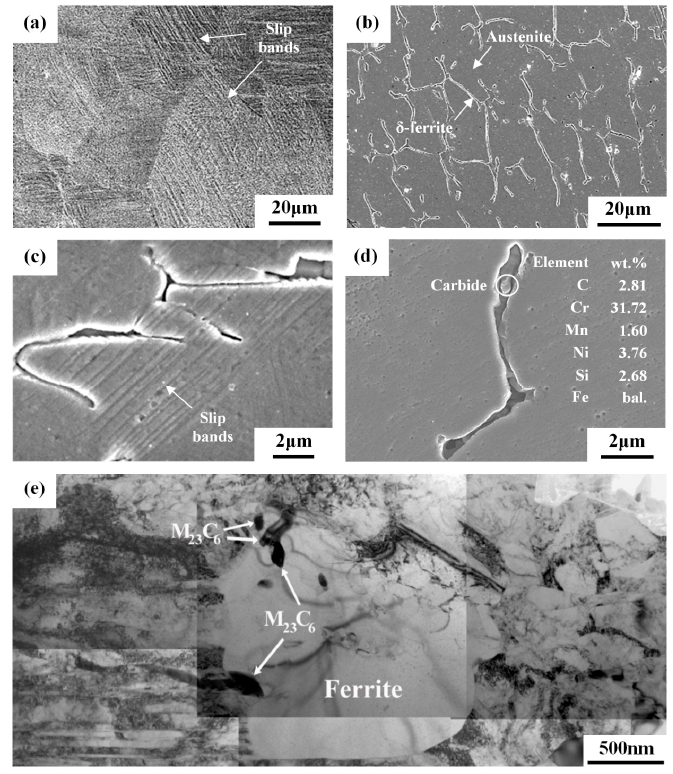
Figure 1. SEM micrographs of the ( a ) 304L-CR; ( b ) 308L-AW; ( c ) 308L-CR; ( d ) 308L-CRS specimens, and ( e ) TEM micrograph of 308L-CRS specimen.